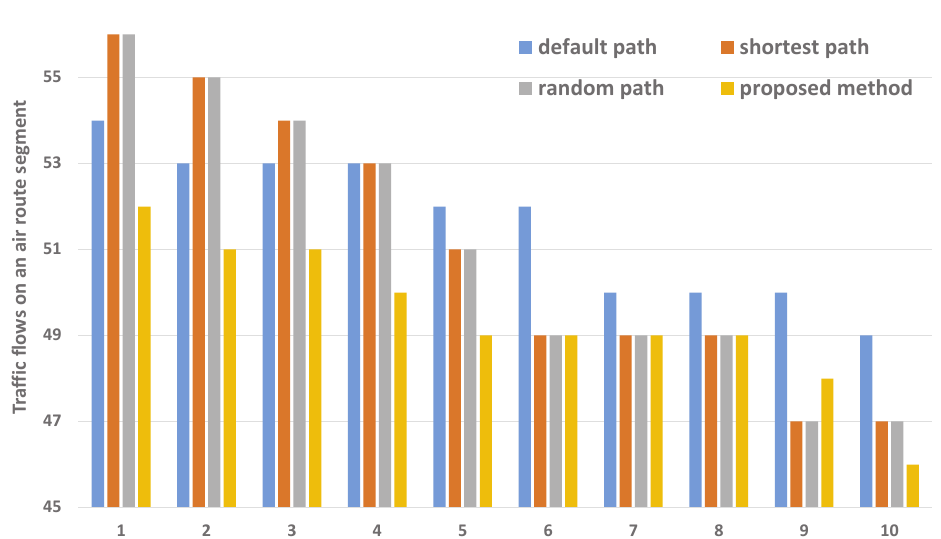
Figure 6. The first ten traffic flows of an air route network in the time interval 9:00–10:00 under different routing-path